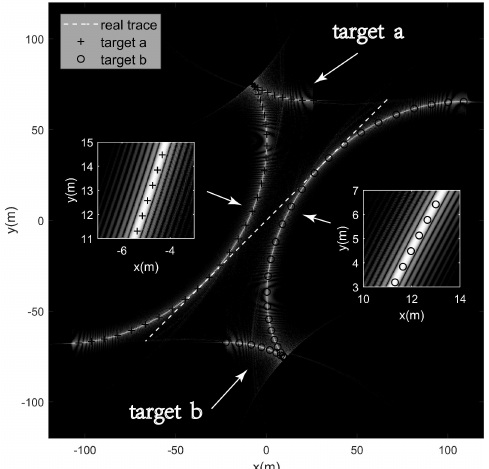
Figure 12. Target’s real trace, estimated image trace, and moving target SAR image. Targets a and b moved at 4 m/s along the dashed line but in opposite directions. Target a moved from the top right to the bottom left, while target b moved from the bottom left to the top right. The estimated image traces of targets a and b are plotted with ‘+’ and ‘o’ symbols,